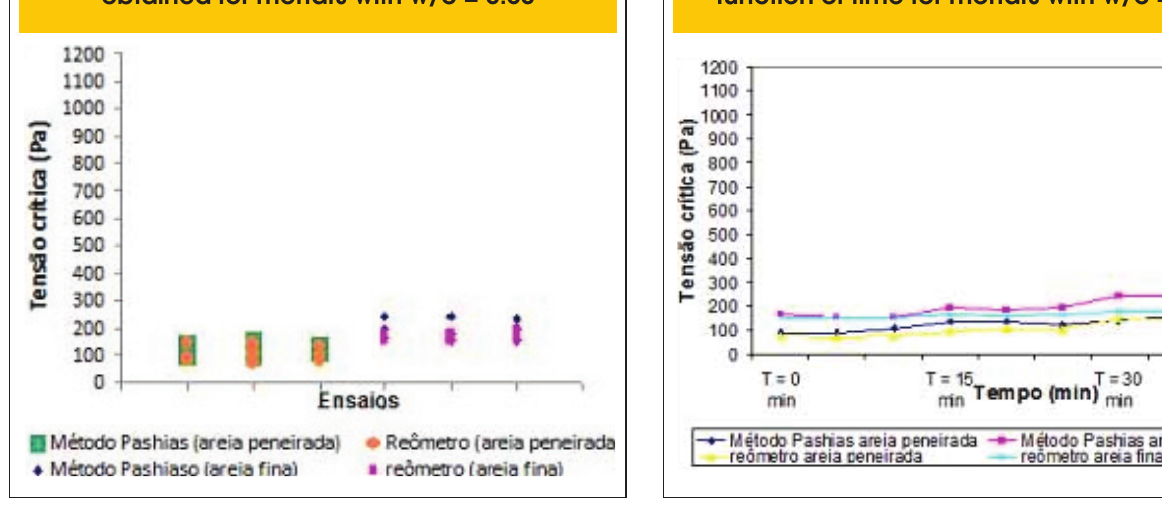
Figure 15 – Behavior of the yield stress as function of time for mortars with w/c = 0.50